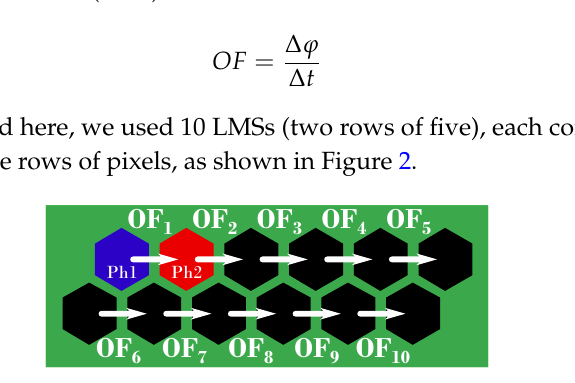
Figure 2. The 12 Michaelis–Menten pixels (Figure 1b) and the 10 corresponding local motion sensors (LMSs). LMSs are unidirectional and can only measure the OF magnitudes OF i i ∈ { 1,...,10 } in 1D. The optics geometry of the first two-pixel LMS (composed of the red and blue pixels) is described in Figure